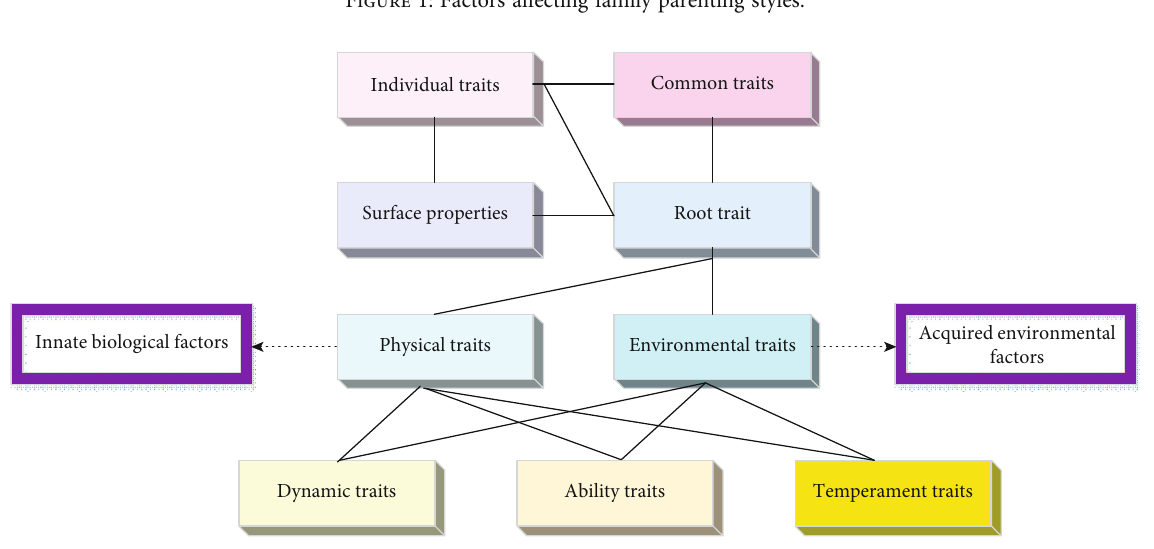
Figure 2: Theory of personality trait. Table 3: Cronbach α coe ffi cient of Ry ff Psychological Well-being Scale.